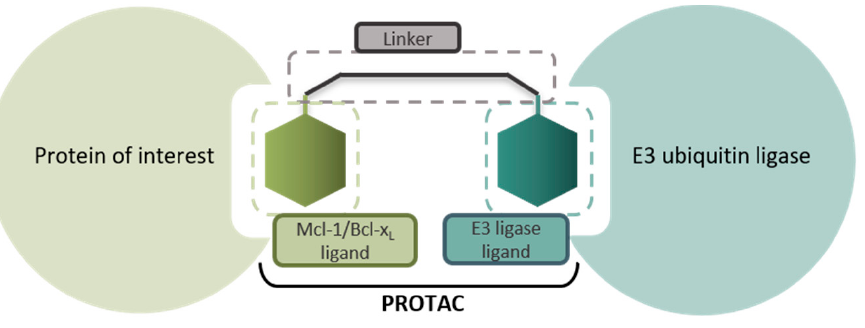
Figure 28. Structure of our PROTAC